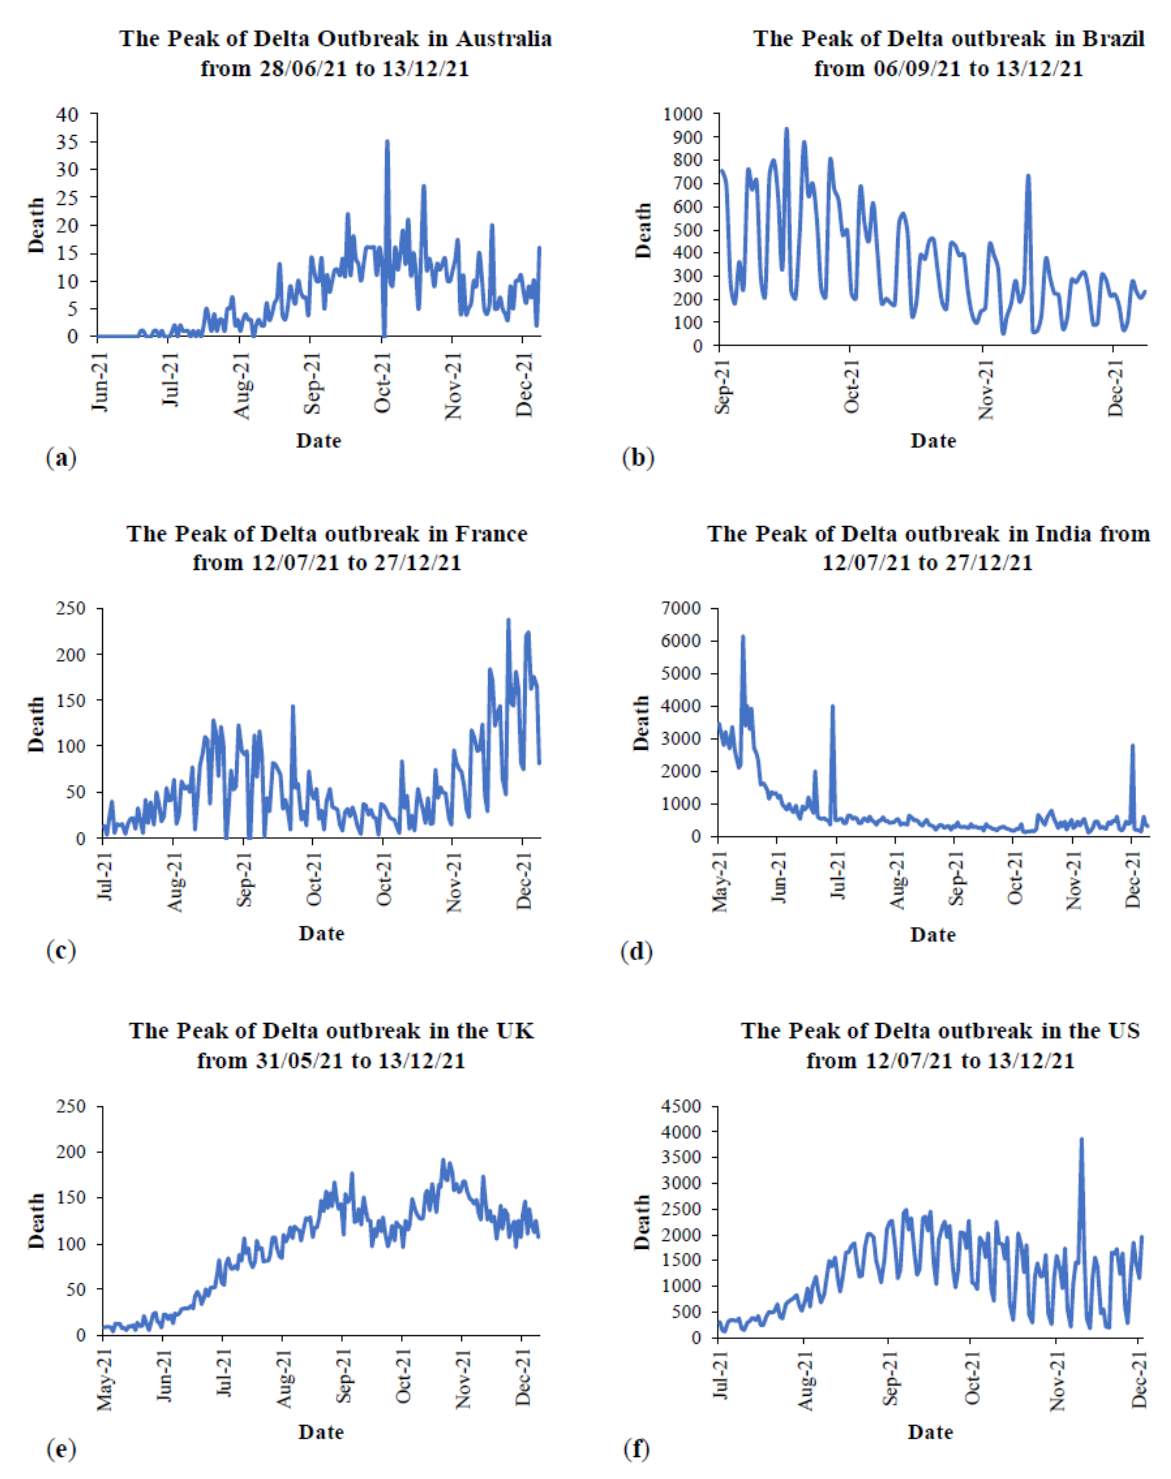
Figure 16. Mortality during the peak of Delta outbreaks in: ( a ) Australia, ( b ) Brazil, ( c ) France, ( d ) India, ( e ) the UK, and ( f ) the US [64].